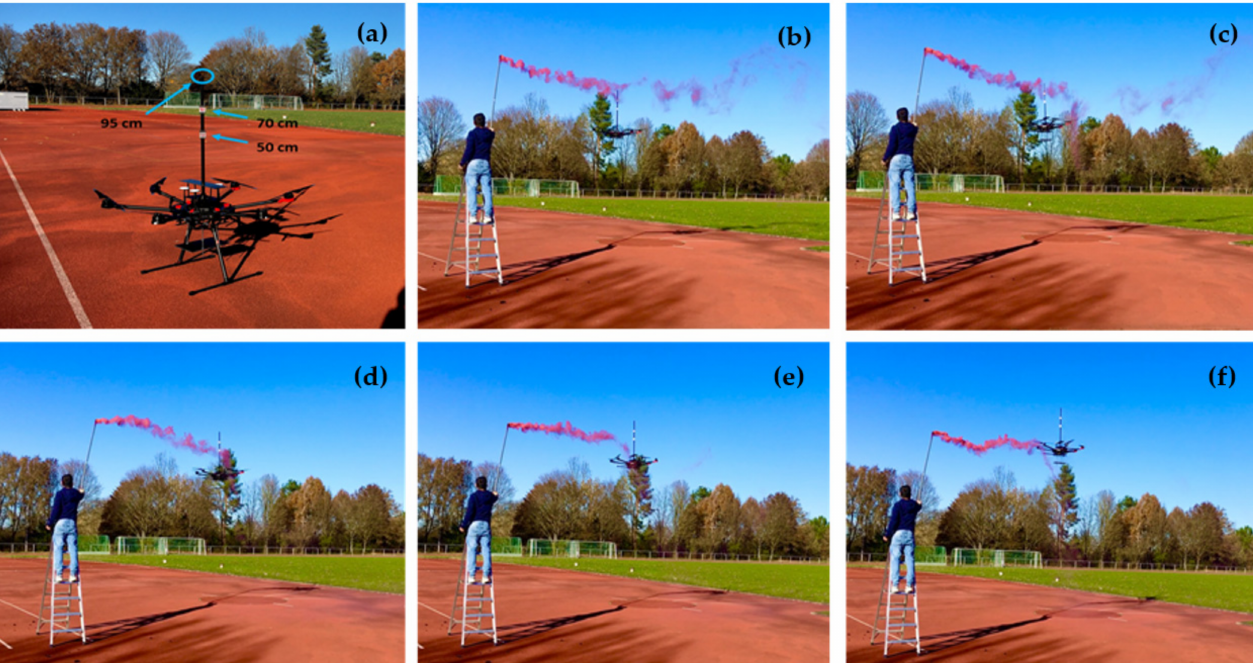
Figure 2. Investigation of the downwash flow caused by the propellers of the Hexacopter UAV (DJI M600 PRO) using a red colored smoke cartridge: ( a ) hexacopter UAV arrangement; ( b ) hexacopter UAV about 90 cm below the smoke plume; ( c ) hexacopter UAV about 70 cm below the smoke plume; ( d ) hexacopter UAV about 30 cm below the smoke plume; ( e ) hexacopter UAV about 30 cm below the smoke plume; and ( f ) hexacopter UAV at the same level of the smoke